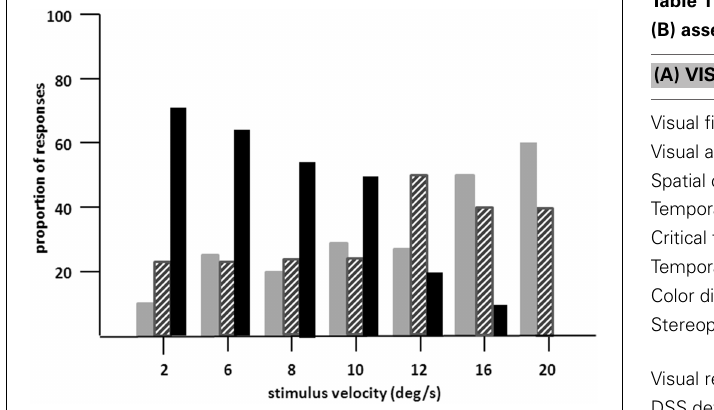
FIGURE 3 | Proportion of “no” (gray bars), “uncertain” (hatched bars), and “yes” responses (dark bars) of LM in 20 trials in stimulus velocities ranging from 2 ◦ /s to 20 ◦ /s. Moving path length was 20 ◦ . LM’s task was to indicate verbally, whether she can see the stimulus in motion (yes responses), was not sure about motion (uncertain responses) or could not see motion at all (no responses; 10 trials per velocity). Presentation time was unlimited, but was usually between 2 and 5s. Note increase in “no” and decrease in “yes” responses with increasing velocities.